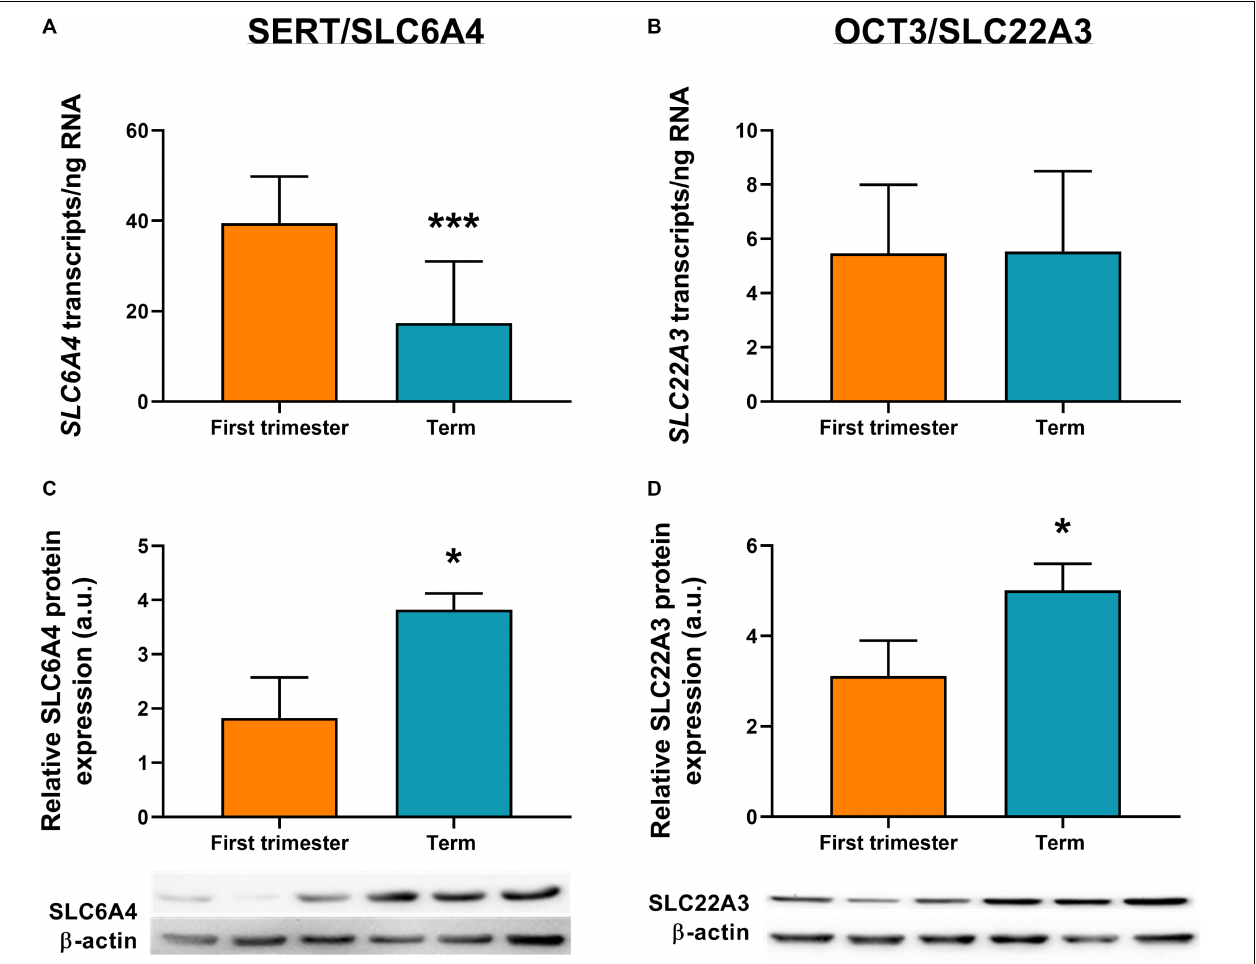
FIGURE 4 | Gene and protein expression of the main transporters of 5-HT pathway. Comparison of gene and protein expression of 5-HT transporter ( SLC6A4 /SERT) and organic cation transporter 3 ( SLC22A3 /OCT3) between the first-trimester and term human placenta was analyzed by digital droplet PCR (A,B) and Western blot (C,D) . Protein expression was normalized to β -actin as a loading control; representative immunoblots for target proteins and β -actin are shown. For ddPCR analysis n = 13 (first trimester) and n = 25 (term placentas); for protein analysis n = 3 for each. Data are presented as mean ± SD and statistical significance was evaluated using unpaired t -test; * p ≤ 0.05, *** p ≤